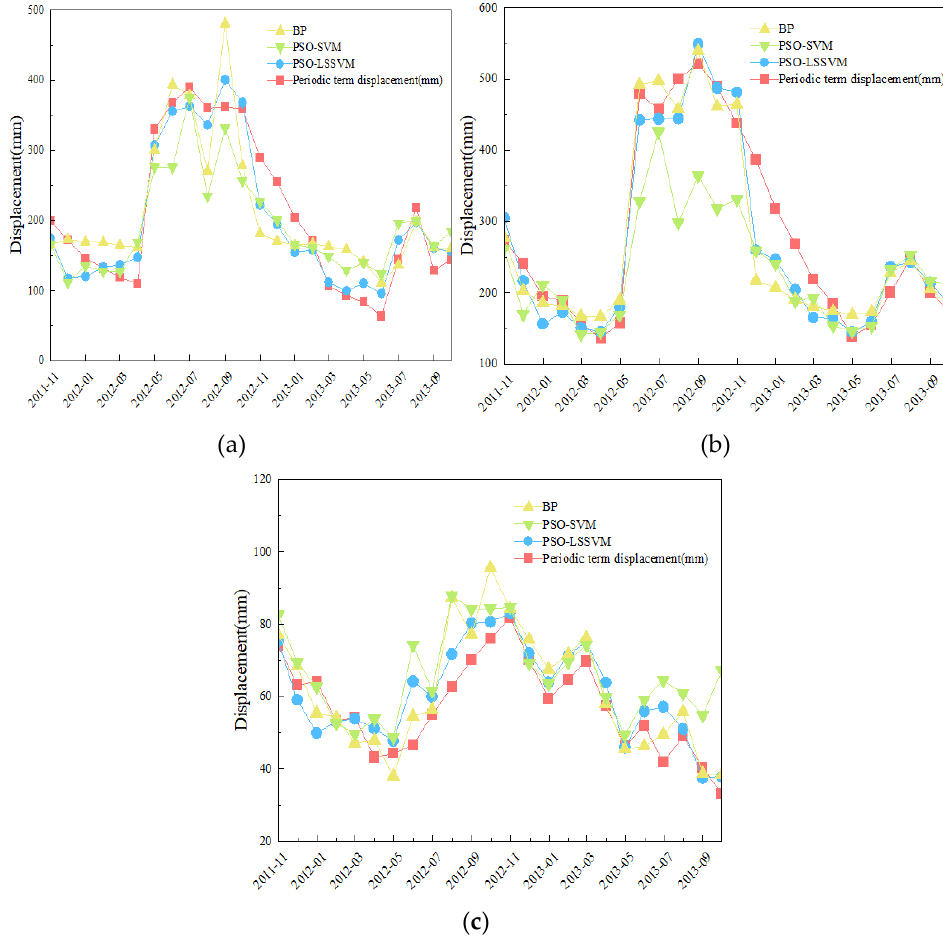
Figure 7. The PTD predicted result: ( a ) ZG85; ( b ) ZG86; ( c ) ZG87. Table 3. The error of the PTD of each